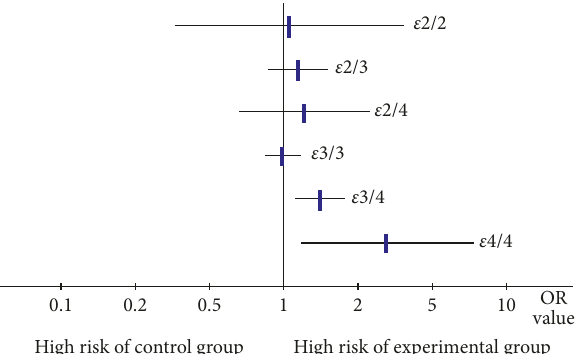
Figure 2: Risk of Parkinson’s disease dementia in those with the five APOE genotypes compared with the ε 3/3 genotype (assessed in 10 studies).